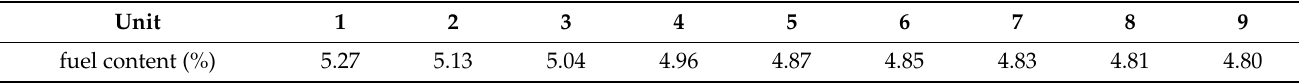
Table 6. The theoretical values of fuel content per